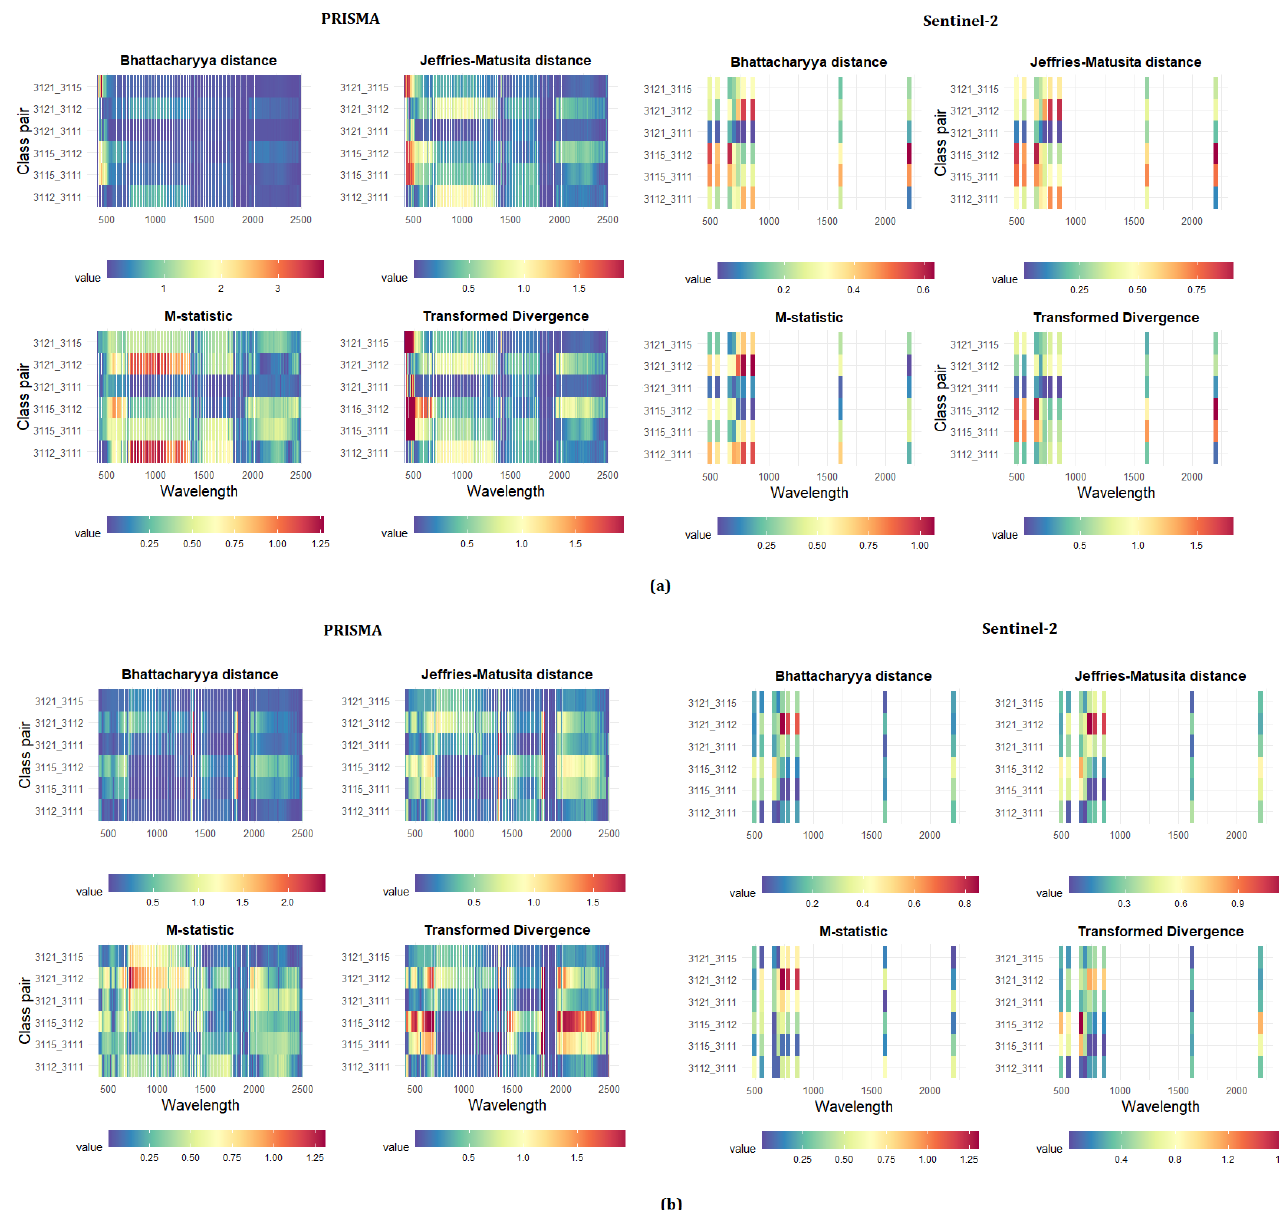
Figure 6. Results of the separability analysis on the fourth level of the nomenclature system, divided by statistical metrics and forest type pairs. Symbology as in Figure 6: ( a ) Area 1; ( b ) Area 2.